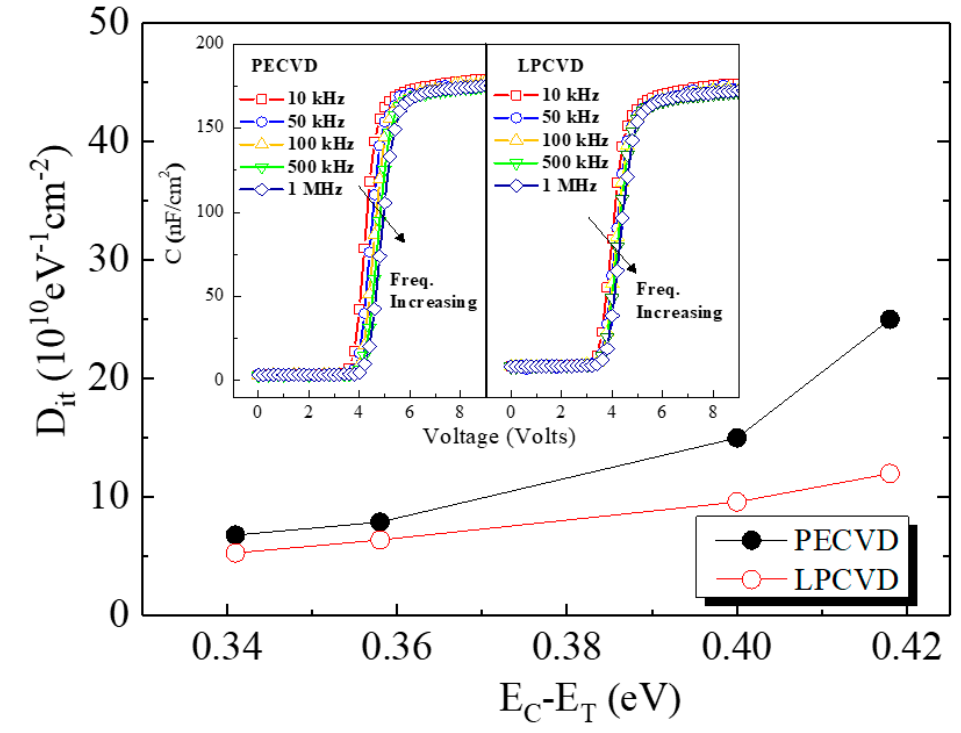
Figure 6. The quasi-static C–V characterization and Dit versus E C -E T of the PECVD- and LPCVD-